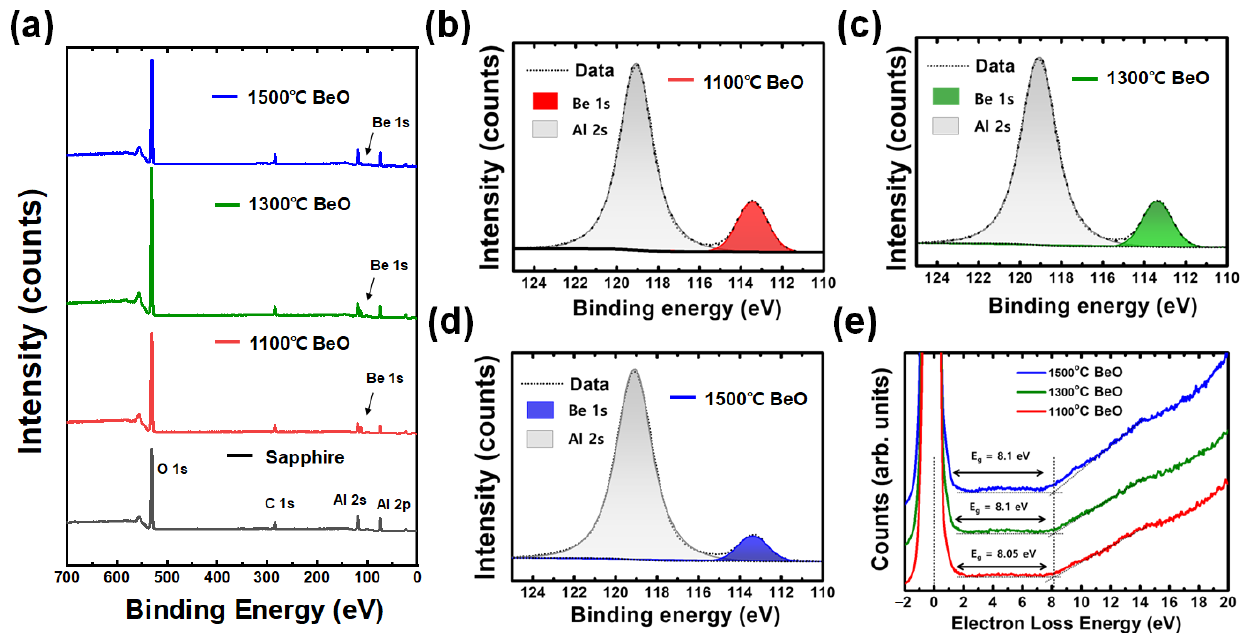
Figure 6. ( a ) X-ray photoelectron spectroscopy (XPS) of the BeO thin films on sapphire substrates as a function of the binding energy from 0 eV to 850 eV and the high-resolution spectrum with fitting results corresponding to Be 1 s (Be-O) and Al 2 s depending on the sintering temperatures of ( b ) 1100 °C, ( c ) 1300 °C, and ( d ) 1500 °C. ( e ) The reflection electron energy loss spectroscopy (REELS) of the BeO thin film is shown.